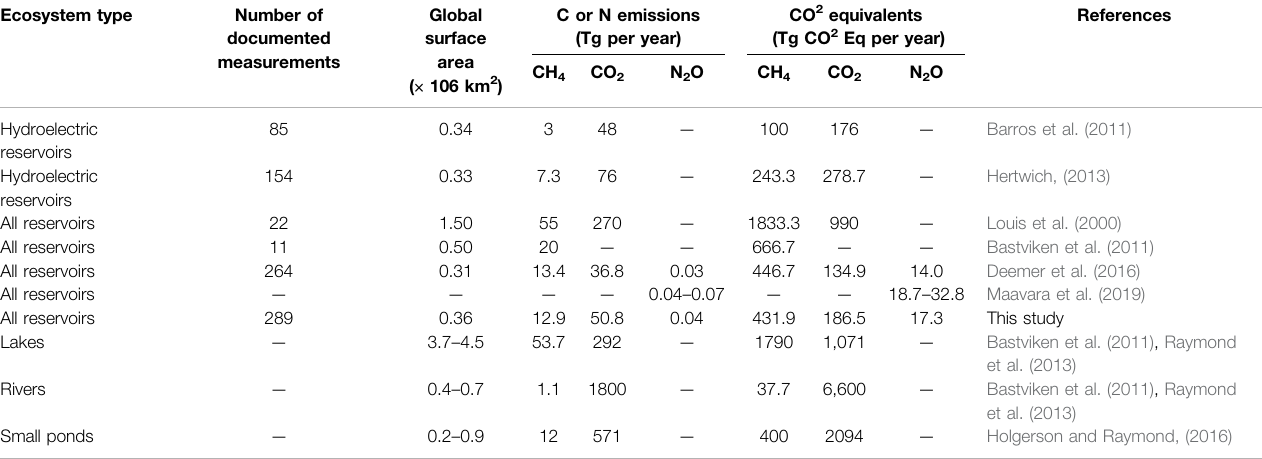
TABLE 1 | Global estimation of GHG emissions from freshwater